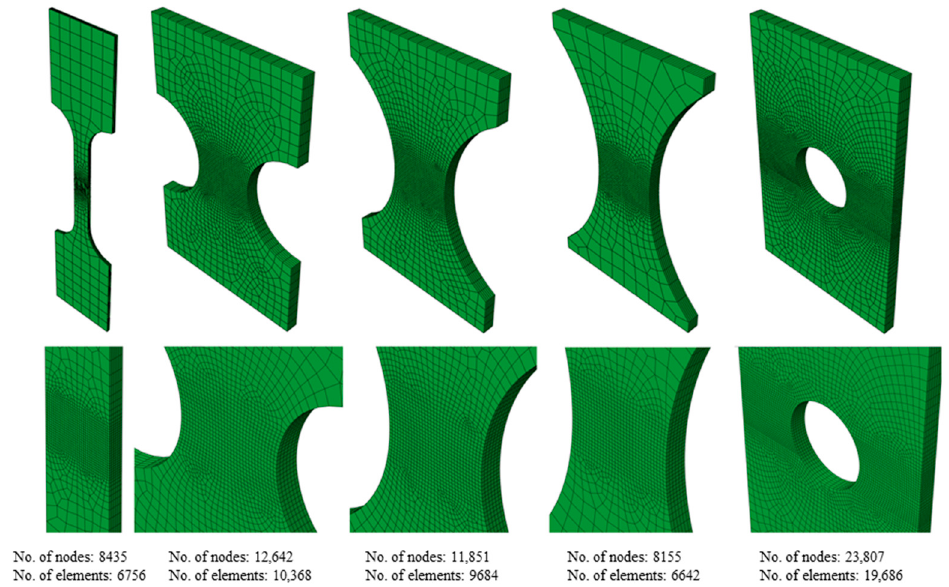
Figure 5. Finite element model for material test of 304L stainless steel. In order to accurately predict the ductile fracture at the failure location of all specimens, the element size was differentiated. In the region of interest, the element size was selected as 200 µm, and the number of elements in the thickness direction of the specimen was 6. To reduce computational cost, a coarse mesh was made outside the region of interest.